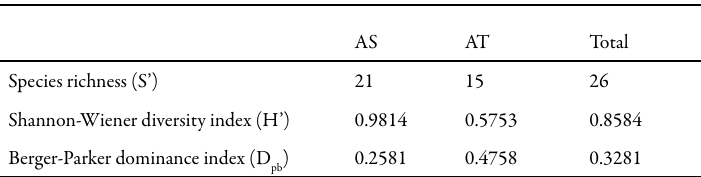
Table 3. Richness, diversity and dominance calculated with active search (AS) and attractive traps (AT) of social wasps in the campus of the “Universidade Federal